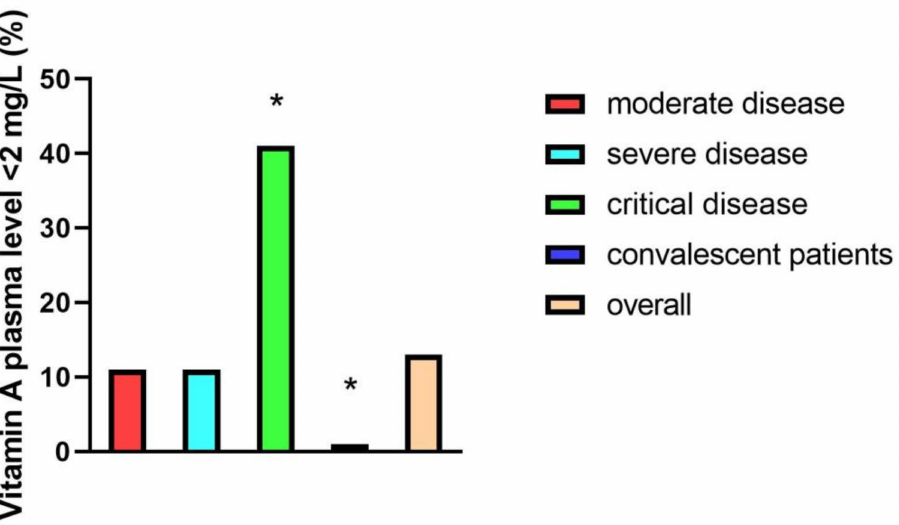
Figure 3. Percentages of patients with vitamin A plasma levels <2 mg/L in different patient groups: moderate disease ( n = 9), severe disease ( n = 9), critical disease ( n = 22), and convalescent patients ( n = 47). Representation of significances according to Bonferroni correction (* p < 0.05).